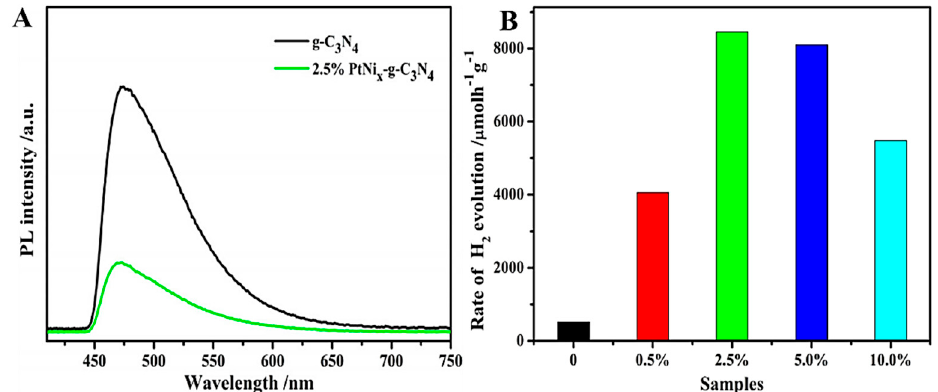
Figure 9. ( A ) Comparison of the photocatalytic H 2 production activity of g-C 3 N 4 , 0.5% PtNi x /g-C 3 N 4 , 2.5% PtNi x /g-C 3 N 4 , 5.0% PtNi x /g-C 3 N 4 , and 10.0% PtNi x /g-C 3 N 4 samples using triethanolamine as the scavenger under a 500 W Xe lamp irradiation. ( B ) Photoluminescence (PL) spectra of 2.5% PtNi x -g-C 3 N 4 and g-C 3 N 4 [337].